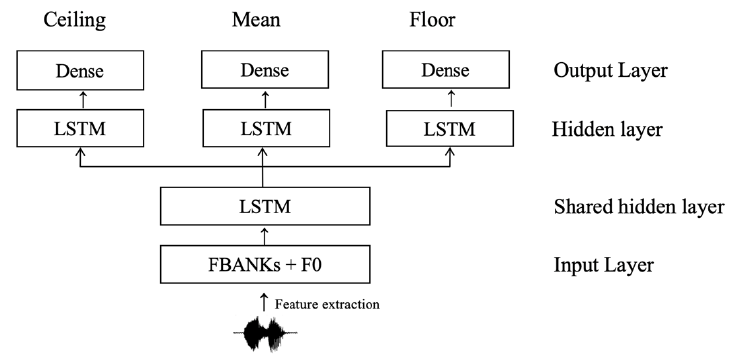
Figure 2. The network structure of the refined model.